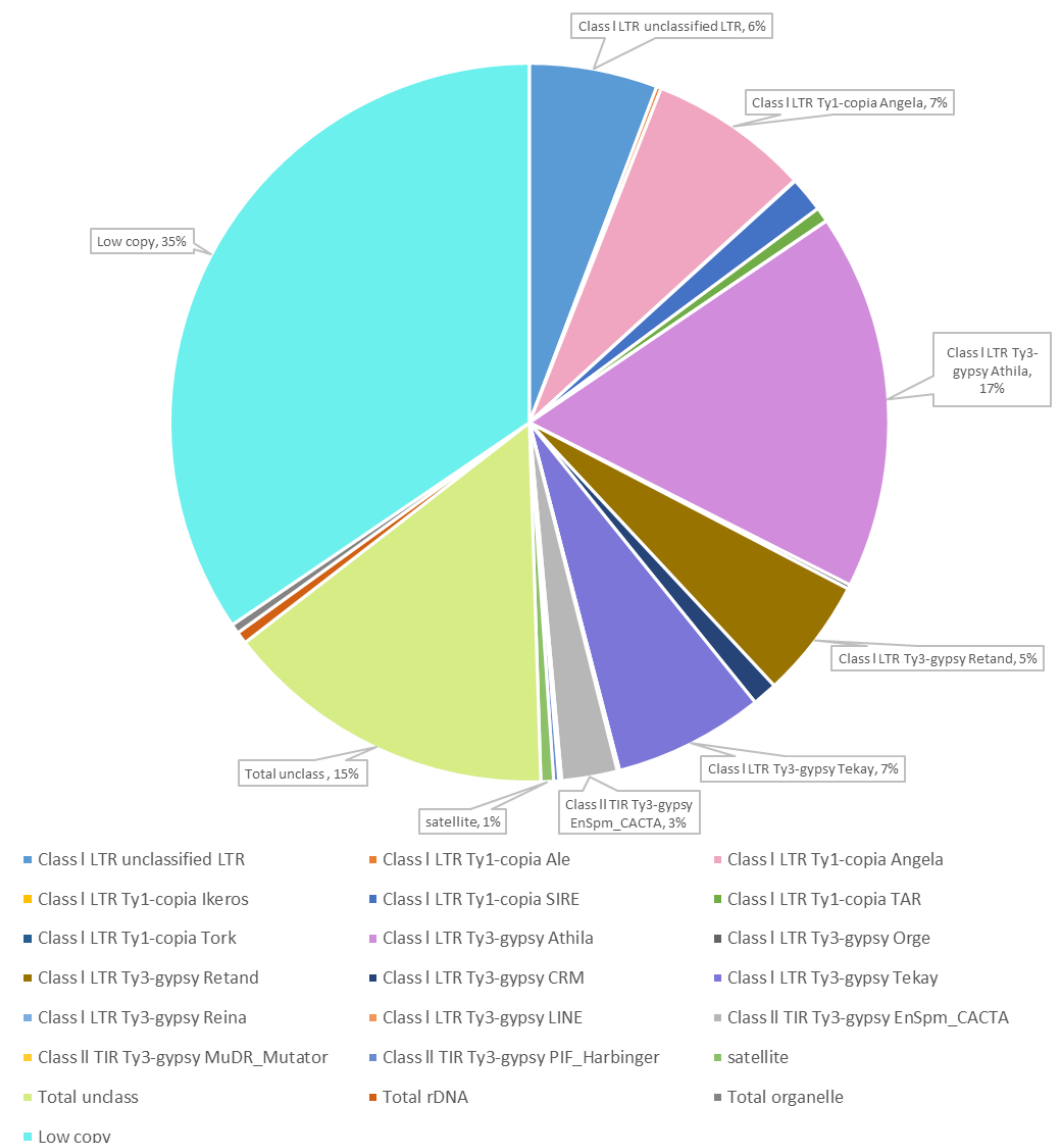
Figure 1. Proportion of repetitive DNA sequences of Thinopyrum ponticum identified after RepeatExplorer2 cluster analysis of whole-genomic Illumina sequencing data.